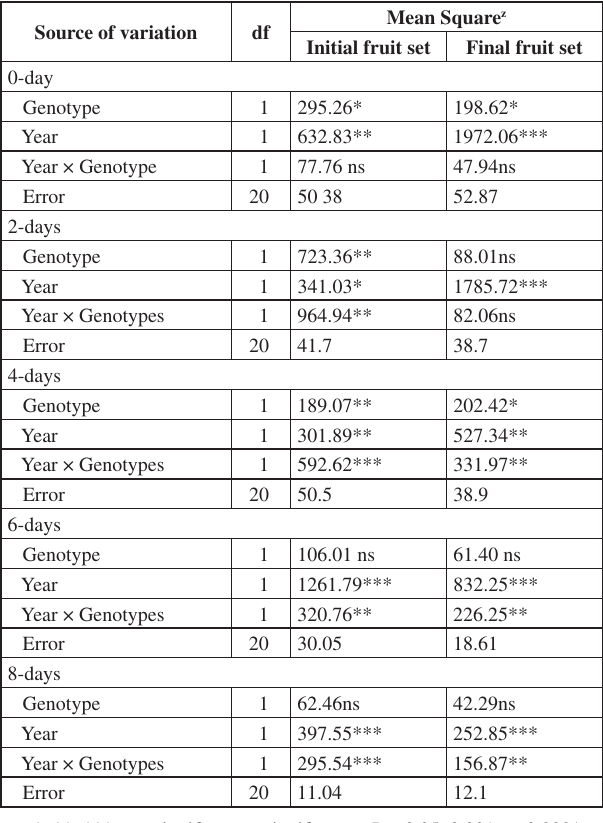
Table 2. Analysis of variance for initial and final fruit set at each pollination time in 2008 and